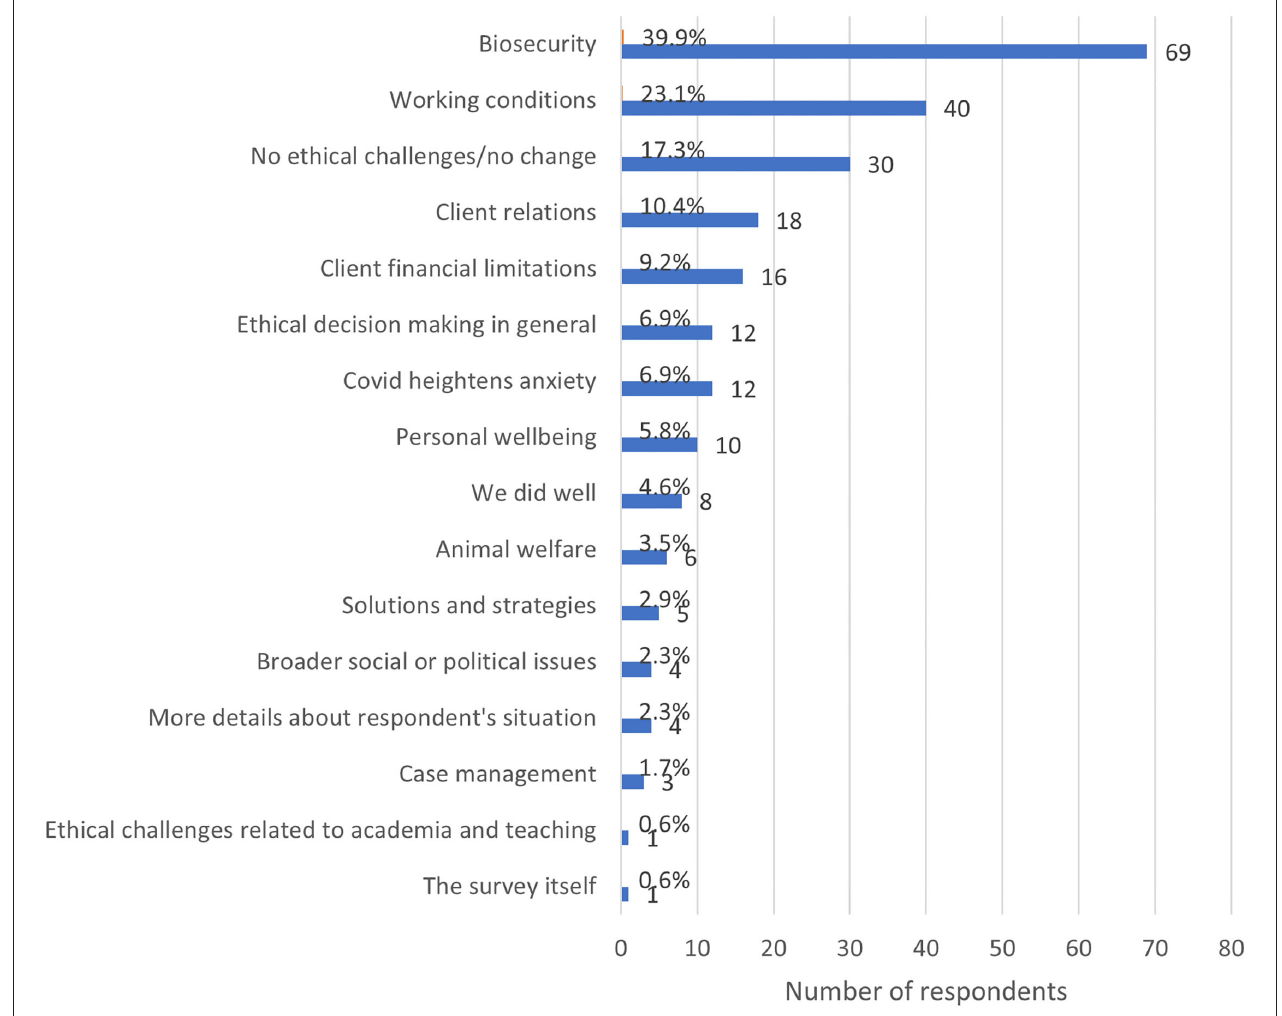
FIGURE 10 | Frequency of major themes from respondent’s additional comments regarding ethically challenging situations during the COVID-19 pandemic, based on the responses of 173 veterinarians, animal health technicians and veterinary nurses, surveyed between May and July in 2020. Note that a single response could be coded for multiple